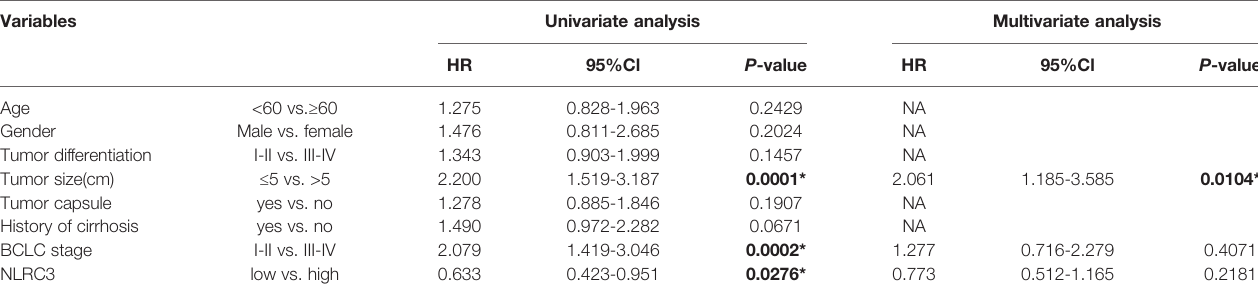
TABLE 2 | Univariate and multivariate analysis of clinicopathological and NLRC3 for overall survival (OS) in patients with HCC (n = 211).